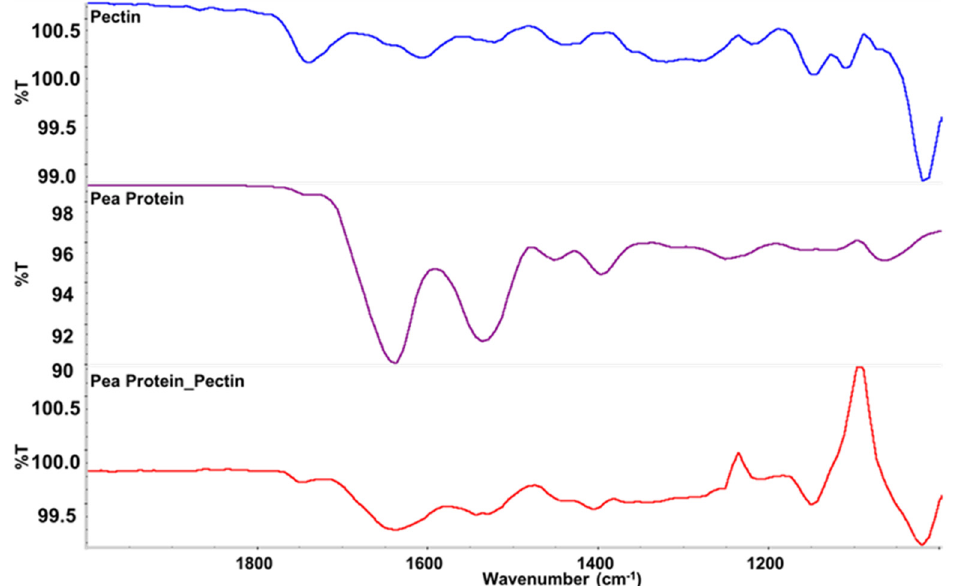
Figure 3. FTIR spectra of powdered pectin, pea protein, and scallop analogs. The scallop analogs consisted of 10% pea protein, 2% transglutaminase, and 0.5% pectin.